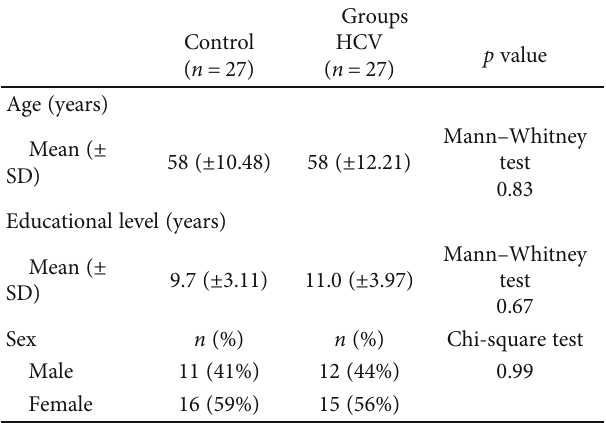
Table 2: Descriptive statistics for age, education level, and sex.